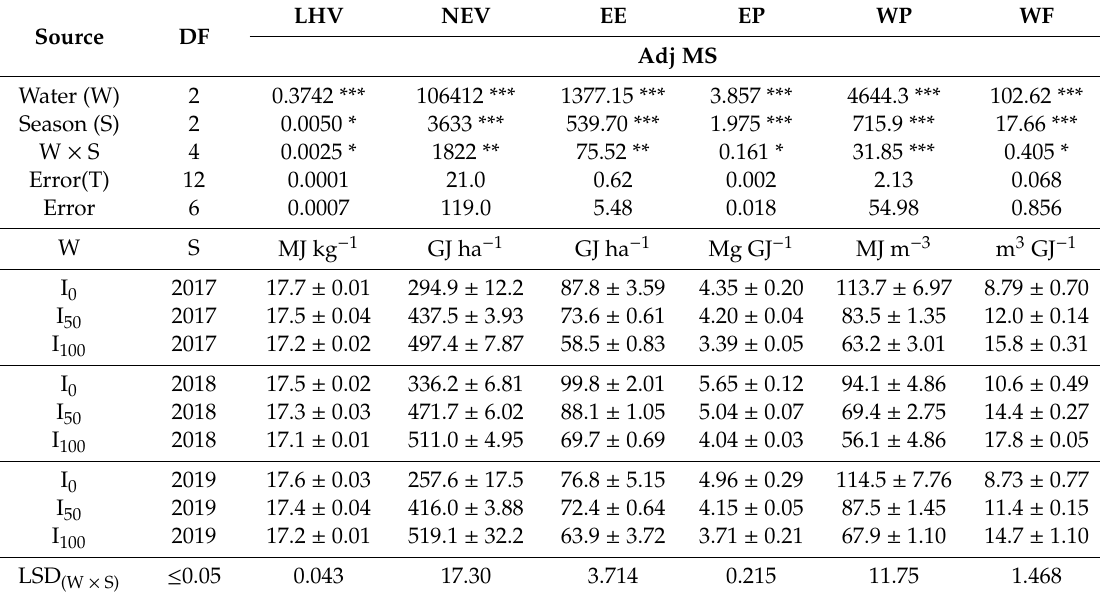
Table 2. Repeated measures ANOVA for main e ff ects and interactions on net energy value (NEV), energy e ffi ciency (EE), energy productivity (EP), water productivity (WP), and water footprint (WF) of Saccharum under changing irrigation (W) and growing season (S). Degree of freedom (DF); adjusted mean square (Adj MS); Significance indicated by * at p ≤ 0.05, ** at p ≤ 0.01, *** at p ≤ 0.001. LSD value indicates a significant “irrigation × growing season” interaction at p ≤ 0.05.